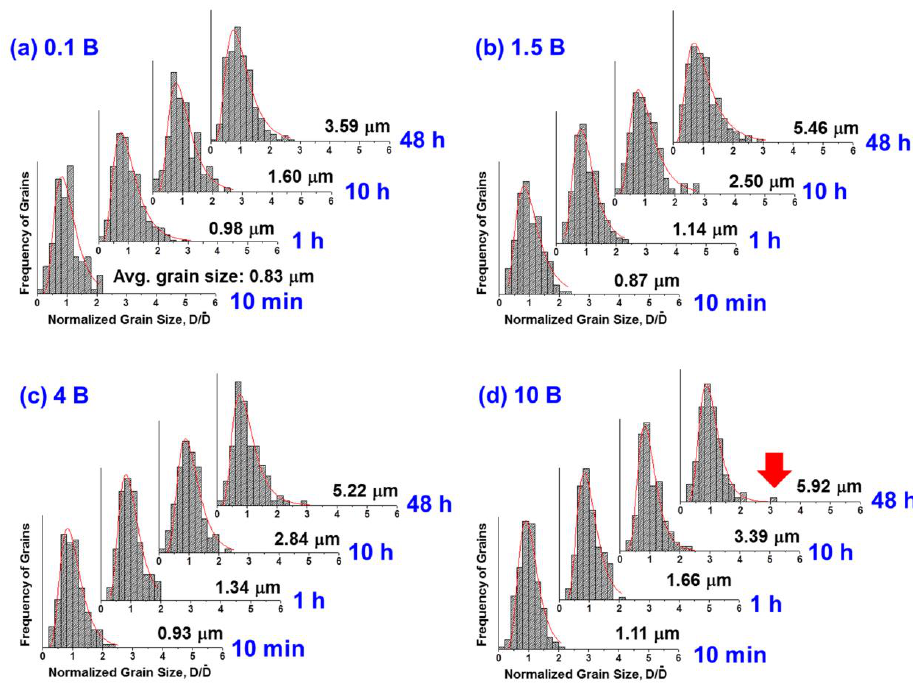
Figure 3. Measured normalized grain size distributions of ( a ) 0.1 mol%, ( b ) 1.5 mol%, ( c ) 4 mol%, and ( d ) 10 mol% Bi 2 O 3 -excess 0.95(Na 0.5 Bi 0.5 )TiO 3 -0.05BaTiO 3 (NBT–5BT) samples sintered at 1200 °C for various sintering times.